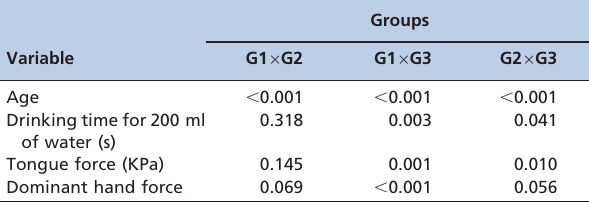
Table 2 - Mann-Whitney test, adjusted by the Bonferroni correction, to identify which groups differed from the others upon pairwise comparison.